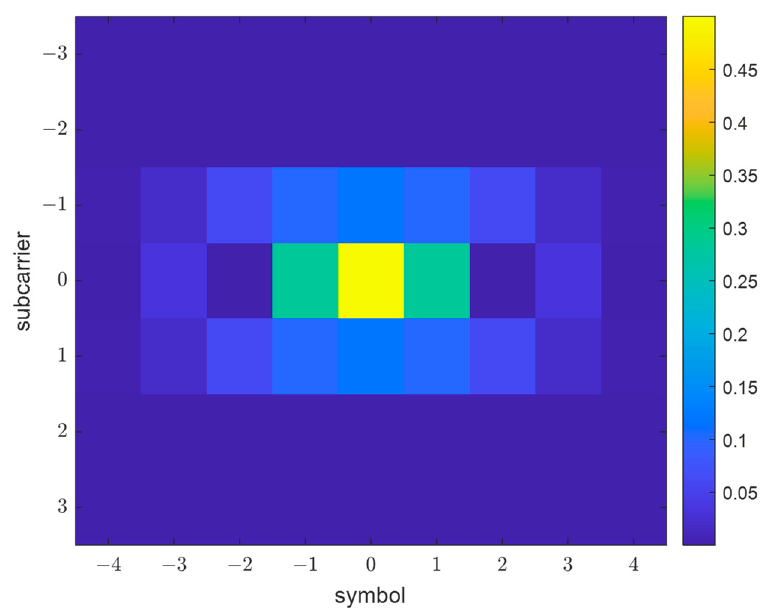
Figure 1. PHYDYAS prototype filter ambiguity function.